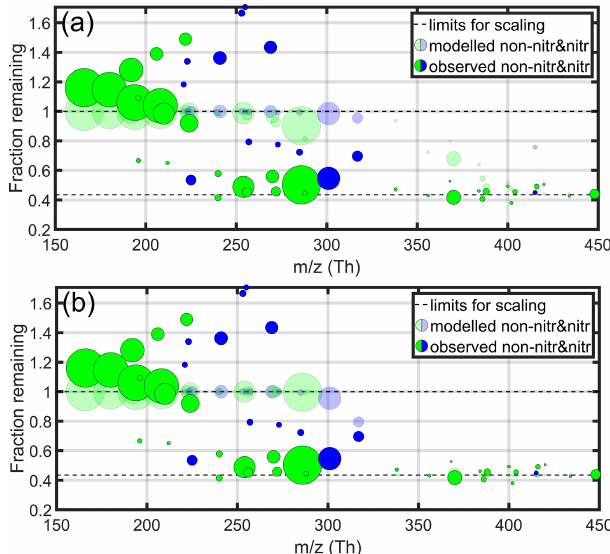
Figure 6. The observed (opaque) and modelled (transparent) de- crease in signal during an ABS seed experiment, for non-nitrate (green) and nitrate (blue) products. Panel (a) compares our obser- vations with the model presented by Peräkylä et al. (2020), while panel (b) compares to the model by Bianchi et al. (2019). Only com- pounds with the best peak fits (FitFactor ≥ 0.7) are shown. The cir- cle sizes are based on the relative sizes of the initial signals before the ABS aerosol injection, with the exception of the two biggest signals, which were slightly scaled down. The condensation sink was approximately 0 . 85 × 10 − 2 s − 1 , meaning that these points cor- respond to the circles with a black outline in Fig. 5. All molecules were charged with a nitrate ion, which has a mass-to-charge ratio of 62Th. One outlier (C 5 H 7 NO 6 ) is not shown as its signal more than